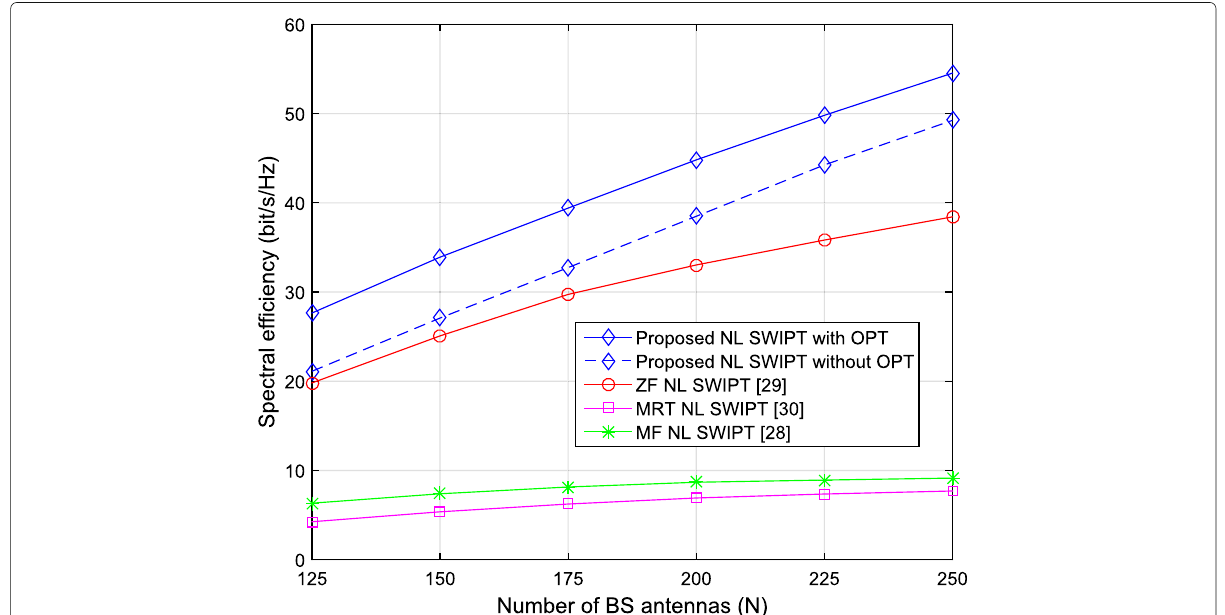
Fig. 7 Spectral efficiency of the proposed SWIPT protocol with the varying of the number of antennas, the channel coherent time is 300 symbols. The transmit power of the BS is set to 46